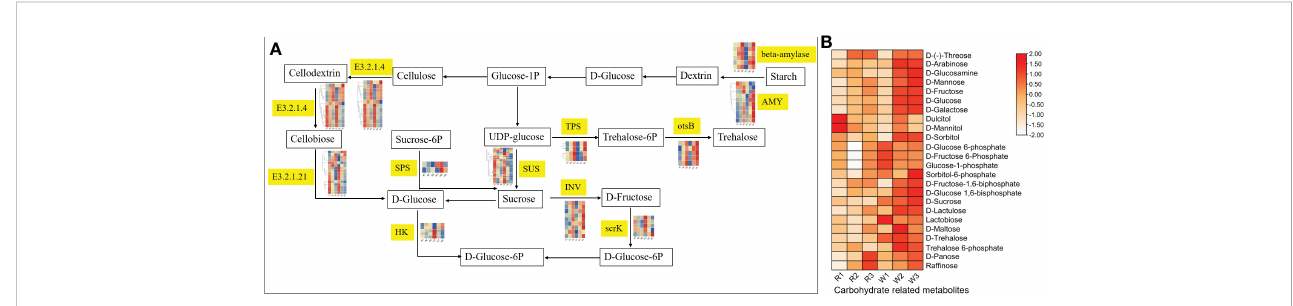
FIGURE 4 Changes of the gene expression and metabolite accumulation levels of nut fl owers in the starch and sucrose metabolism pathway. (A) Flow diagram of the starch and sucrose metabolism pathway in different nut fl ower development groups. The words in yellow background indicate the names of the genes involved in the pathway. The small heat map corresponding to the gene name represents the gene expression in the different groups of nut fl ower. The red and blue colors in the small heat map indicate upregulated and downregulated gene expression, respectively. (B) Accumulation patterns of the carbohydrates involved in the starch and sucrose metabolic pathway in the red (R) and white (W) nut fl owers. In the heat map, the red and blue colors indicate upregulated and downregulated metabolite accumulation,